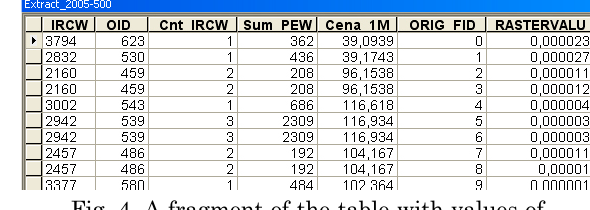
fig. 4. A fragment of the table with values of respective rasters from 2004 as a result of data extraction and placed over the points representing transactions in 2005 (range of kernel function – 500 metres) Source : own study.